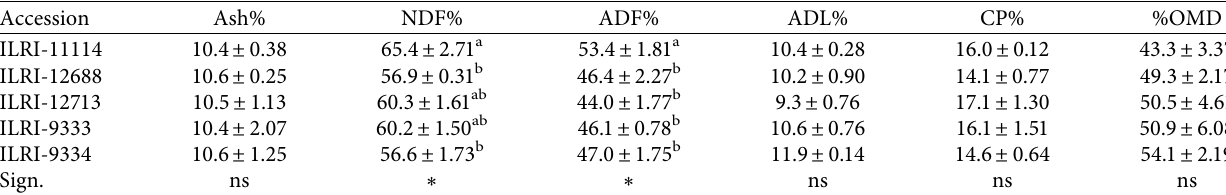
Figure 1: Interaction plot of 5 cowpea accessions in 6 environments (where AS 14 is Assosa in 2014, AS15 is Assosa in 2015, AS16 is Assosa in 2016, K14 is Kamashi in 2014, K15 is Kamashi in 2015, and K16 is Kamashi in 2016). Table 5: Nutrient content of cowpea biomass from 100% DM (mean ± SE).